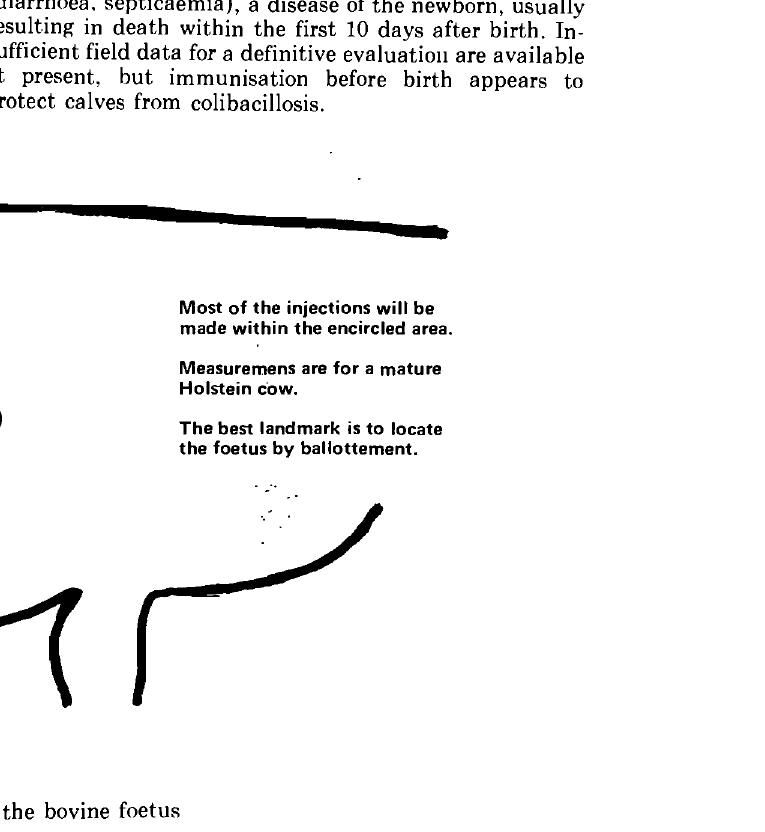
Fig. 1: In Utero vaccination of the bovine